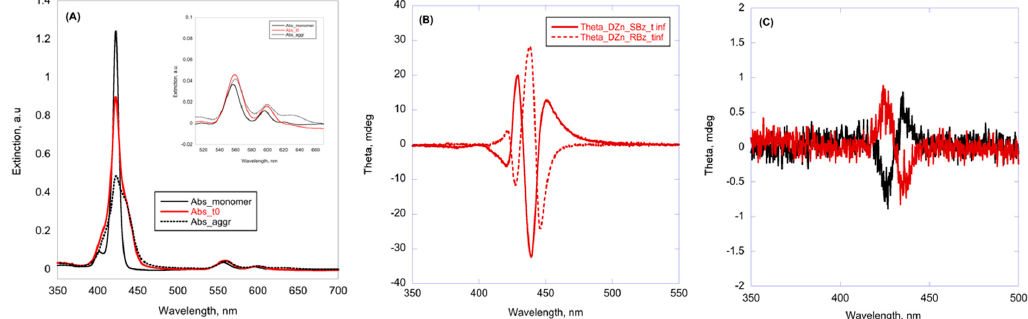
Figure 1. ( A ) UV-Vis spectra of ( D )ZnP(-) in the presence of ( S )-1-phenylethanamine: in the